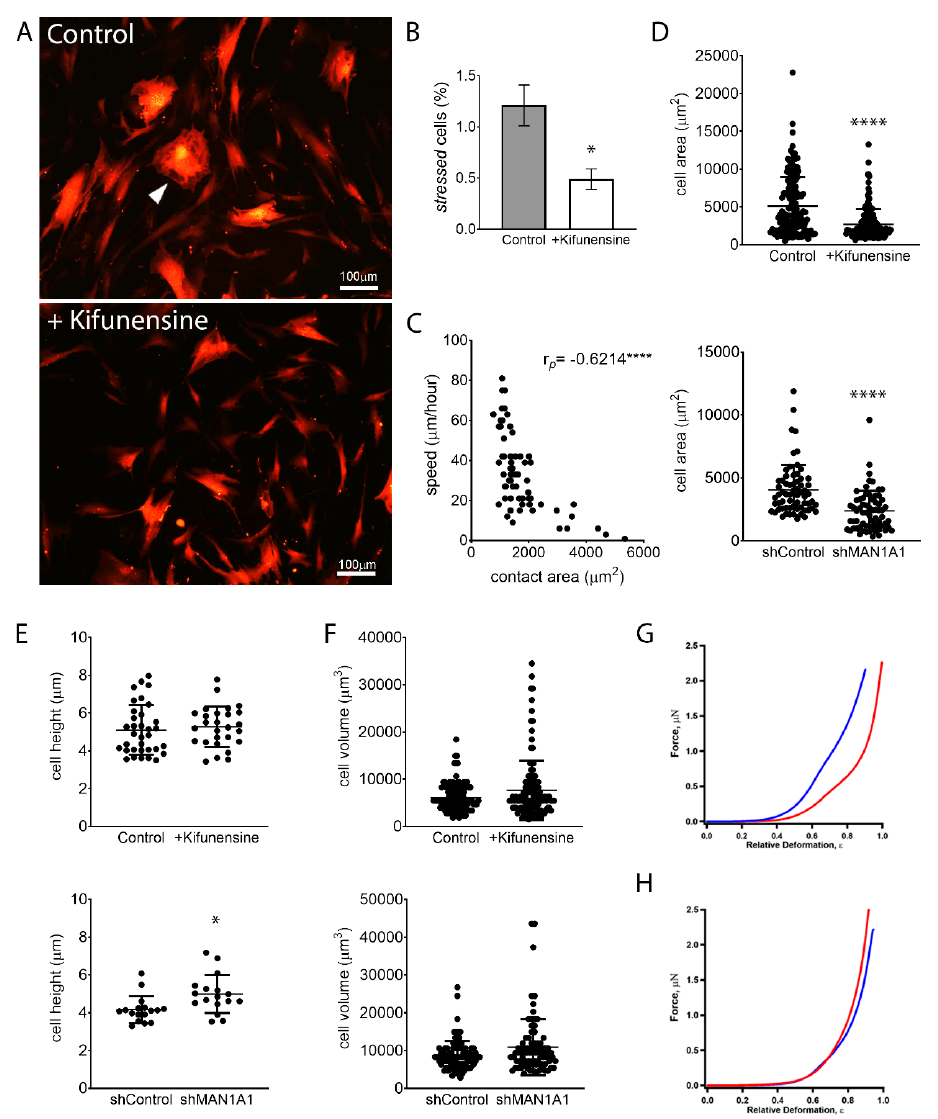
Figure 4. High mannose N-glycans promote changes in cell shape. ( A ) Representative images of MSCs expressing tdTomato, treated with or without Kifunensine. A “stressed” cell is indicated with the white arrowhead. Cells with Kifunensine also tend to look smaller. ( B ) Semiquantification of “stressed” cells (cells with morphological features as shown in A) ( n = 4). ( C ) Correlation of cell size (contact area) and speed, as measured in control cells. Dots indicate individual cells and Pearson’s coefficient is shown in the upper right corner. ( D ) Contact area measured on cells visualized under a phase-contrast microscope. ( E ) Cell height measured by AFM. ( F ) Cell volume calculated by measuring cell radius on cells in suspension (under hemocytometer). For ( D – F ), n = 3 for both top and bottom graphs. ( G ) Force–deformation profiles of a representative shControl (blue) and shMAN1A1 (red) cell. ( H ) Force–deformation profiles of representative control (blue) versus Kifunensine-treated (red) cells. * p < 0.05, **** p < 0.00005.